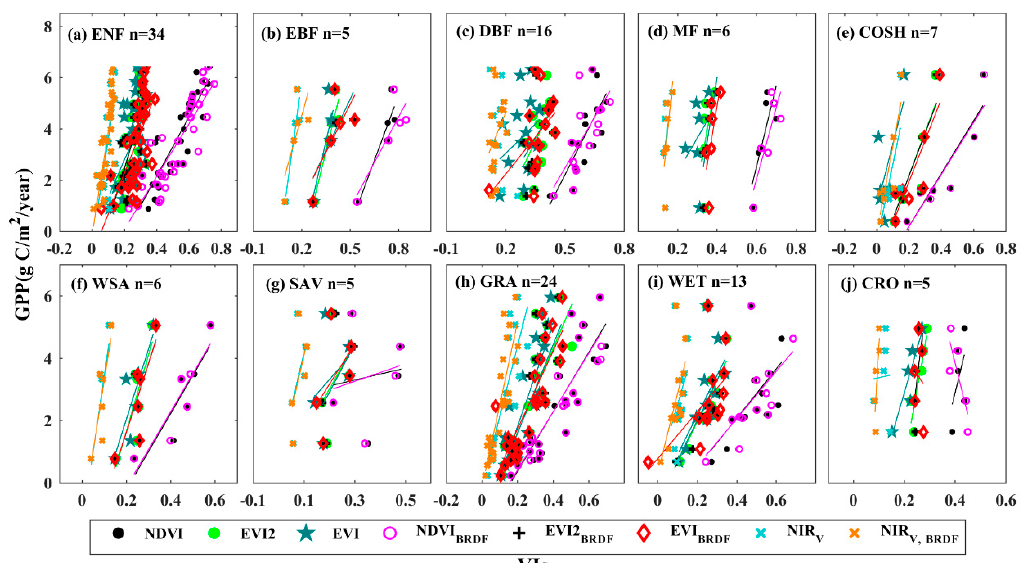
Figure 4. The relationships between VIs and tower GPP across all sites for each biome. The R 2 values for the relationships between VIs and tower GPP at each biome were provided in Table 1. The biome types are as follows: evergreen needleleaf forest (ENF); evergreen broadleaf forest (EBF); deciduous needleleaf forest (DNF); mixed forest (MF); closed and open shrublands (COSH); woody savannas (WSA); savannas (SAV); grasslands (GRA); wetlands (WET); croplands (CRO).